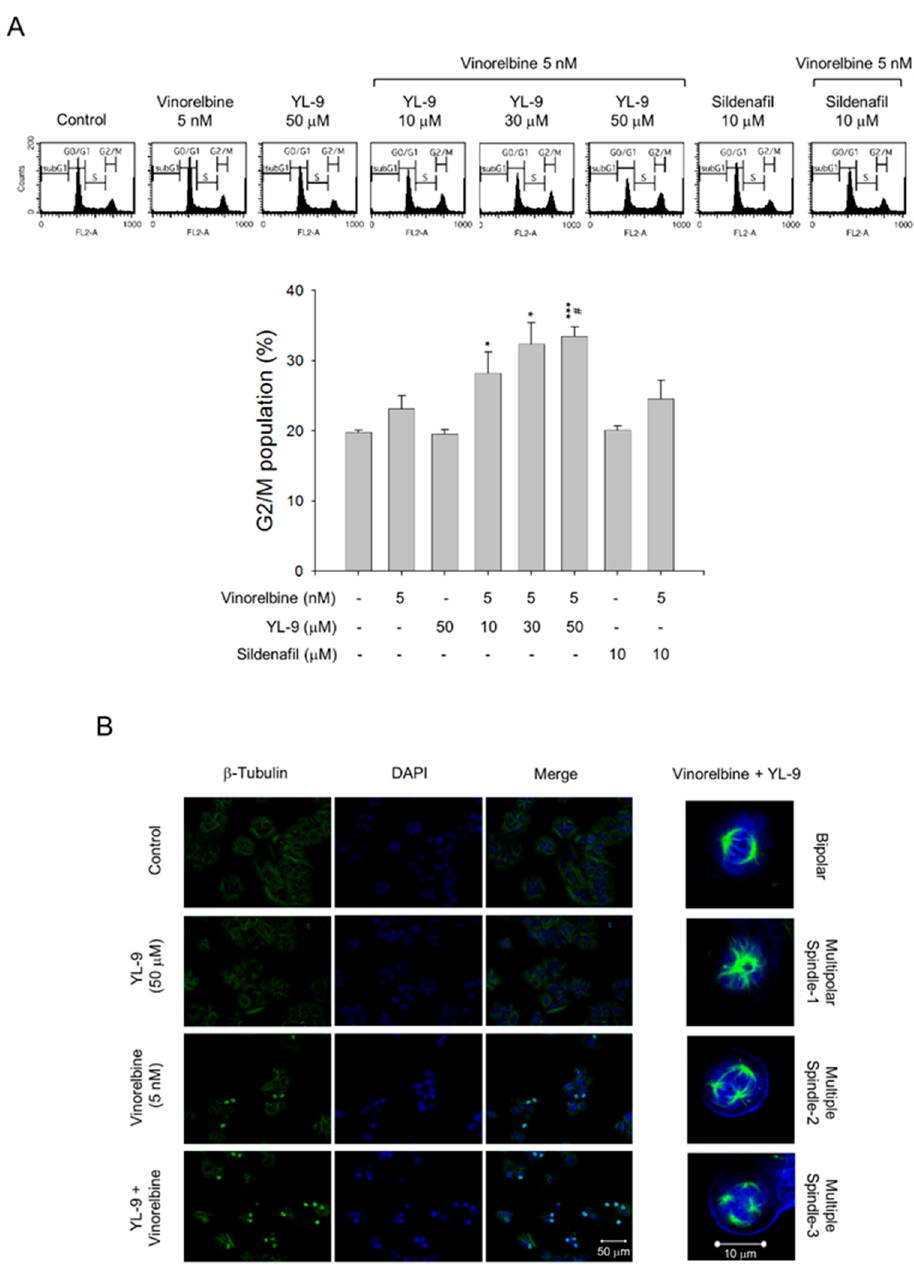
Figure 3. Effect of YL-9 on vinorelbine-induced accumulation of G2/M population and mitotic spindle abnormalities. ( A ) NCI-H460 cells were incubated with the indicated agents for 6 h. After the treatment, the cells were harvested for the detection of cell populations at different cell cycle phases using flow cytometric analysis of propidium iodide staining. The G2/M populations were presented as mean ± SEM of three independent experiments. * p < 0.05 and *** p < 0.001 compared with the control. # p < 0.05 and ## p < 0.01 compared with vinorelbine alone. ( B ) The cells were incubated with the indicated agents for 24 h. After the treatment, the cells were fixed with methanol and stained with β - tubulin antibody (green, microtubules) and DAPI (blue, nucleus). The mitotic spindle organization was detected by immunofluorescence confocal microscopic assay. The organizations of mitotic spindles, including bipolar and multipolar, induced by the combinatory exposure to vinorelbine and YL-9 were demonstrated.